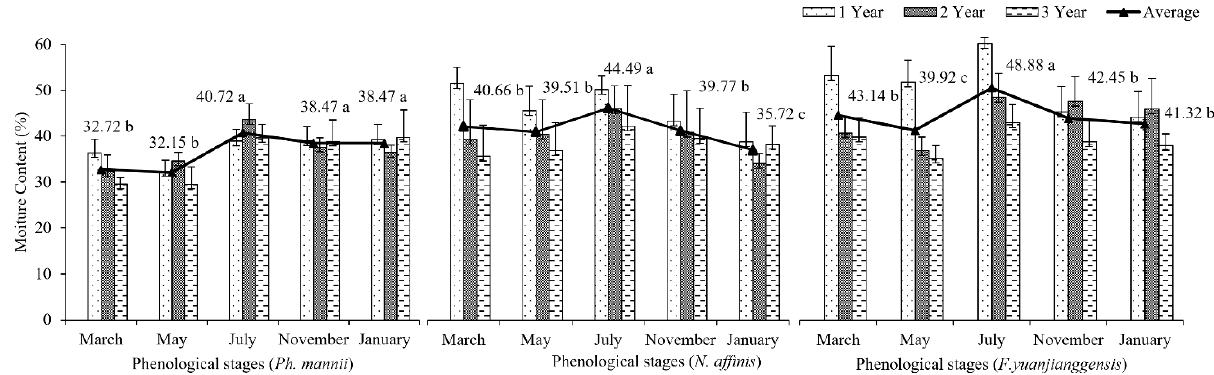
Figure 3. Dynamic changes in the moisture contents of three bamboo types at different phenological stages. Bars are mean values of the parameters from three replicates. Different letters above bars denote the statistical difference among the different phenological stages in each bamboo species at p < 0.05 according to LSD. Error bars represent 95% confidence intervals ( n = 5) (the same hereinafter).